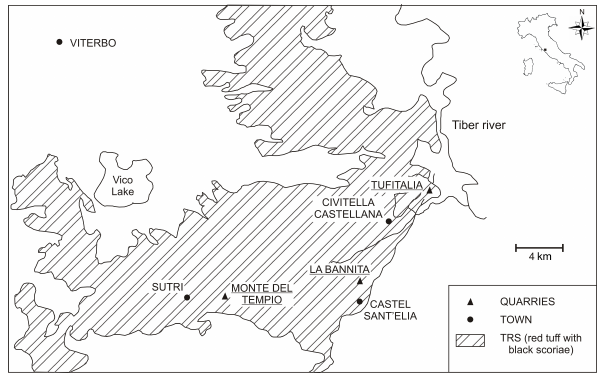
Figure 1. Location map of the different pits (Monte Tempio Tufi- talia and La Bannita) relative to the Ignimbrite C vicanian forma-